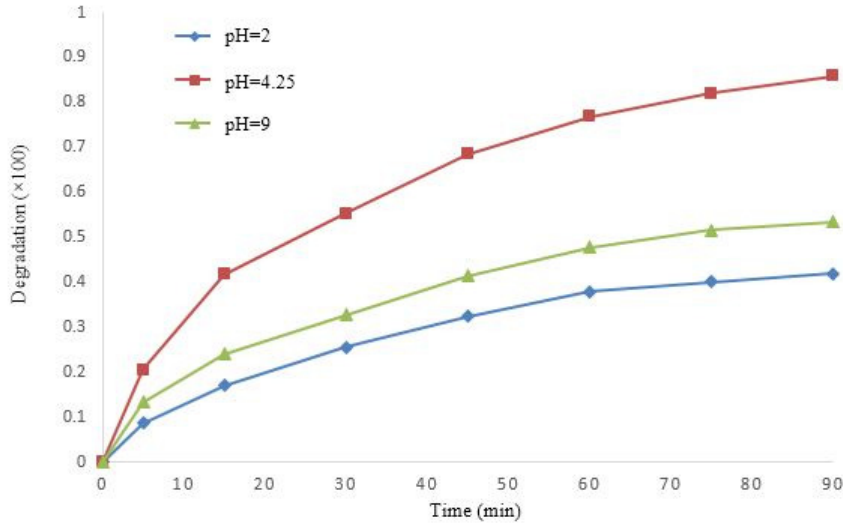
Fig. 9. Effect of Wastewater pH on Catalytic Degradation of